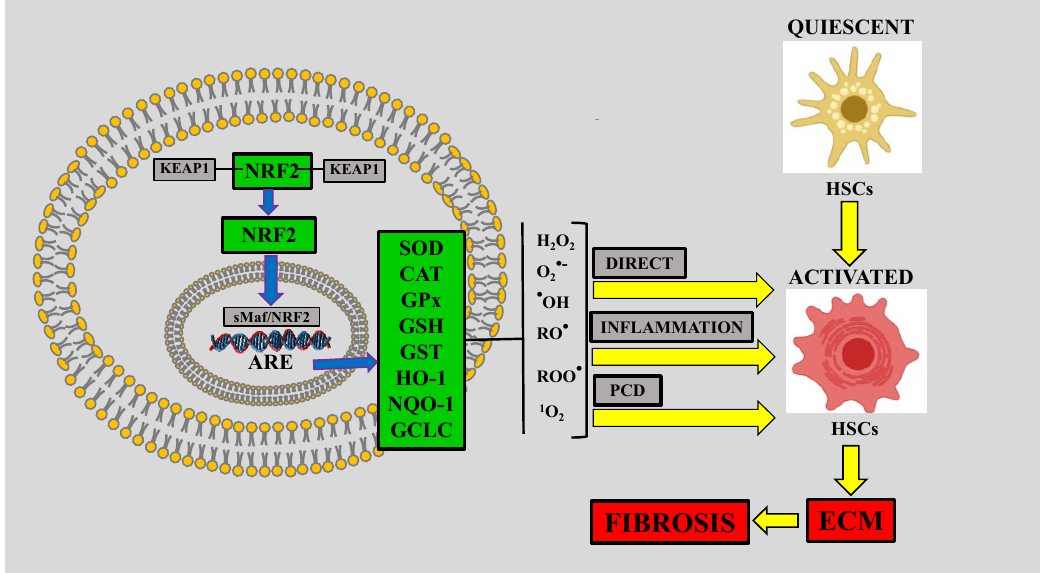
Figure 2. The nuclear factor-E2-related factor-2 (NRF2) pathway exerts antifibrotic e ff ects. Reactive oxygen species (ROS), including hydrogen peroxide (H 2 O 2 ), superoxide anion (O 2 •− ), hydroxyl radical ( • OH), alkoxyl radical (RO • ), peroxyl radical (ROO • ), and singlet oxygen ( 1 O 2 ), can activate hepatic stellate cells (HSCs) directly or by triggering inflammation or programmed cell death (PCD). In turn, activated HSCs produce large amounts of extracellular matrix (ECM) proteins that are conducive to fibrosis. Cells can regulate ROS by inducing the endogenous NRF2 antioxidant system. Inactive NRF2 is bound to the primary oxidative-stress-sensor and cytoskeleton-binding protein Kelch-like erythroid cap-n-collar (CNC) homolog-associated protein 1 (KEAP1) in the cytoplasm. Activated NRF2 is liberated from KEAP1; in turn, free NRF2 translocates to the nucleus and dimerizes with one of the small Maf (sMaf) proteins and binds to the antioxidant response element (ARE), upregulating antioxidant genes, including superoxide dismutase (SOD), catalase (CAT), glutathione peroxidase (GPx), reduced glutathione (GSH), heme oxygenase-1 (HO-1), NAD(P)H dehydrogenase (quinone 1) (NQO-1), and glutamate-cysteine ligase catalytic subunit (GCLC), which are e ff ective in decreasing ROS; therefore, the NRF2 signaling pathway exerts an indirect antifibrotic e ff